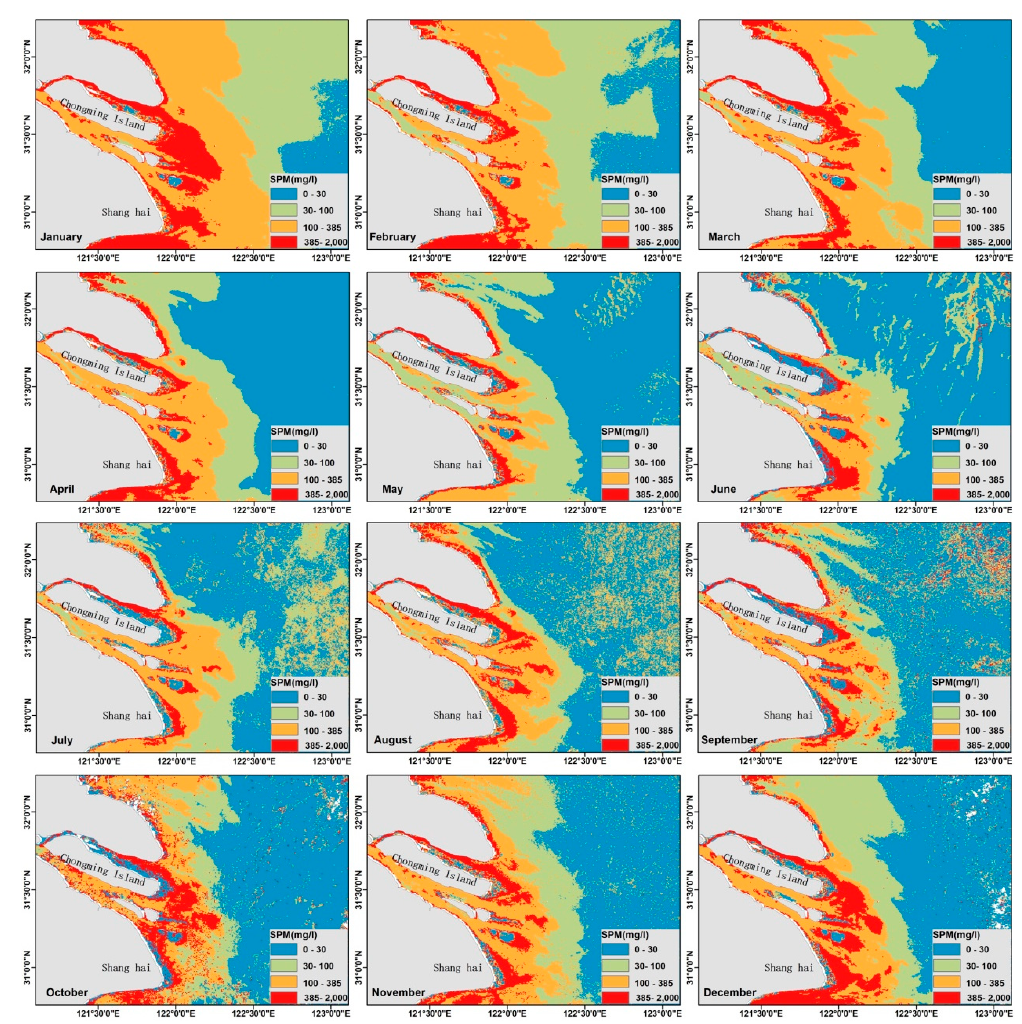
Figure 7. The GOCI-derived SPM distribution in the Changjiang Estuary during each climatological month in 2016.